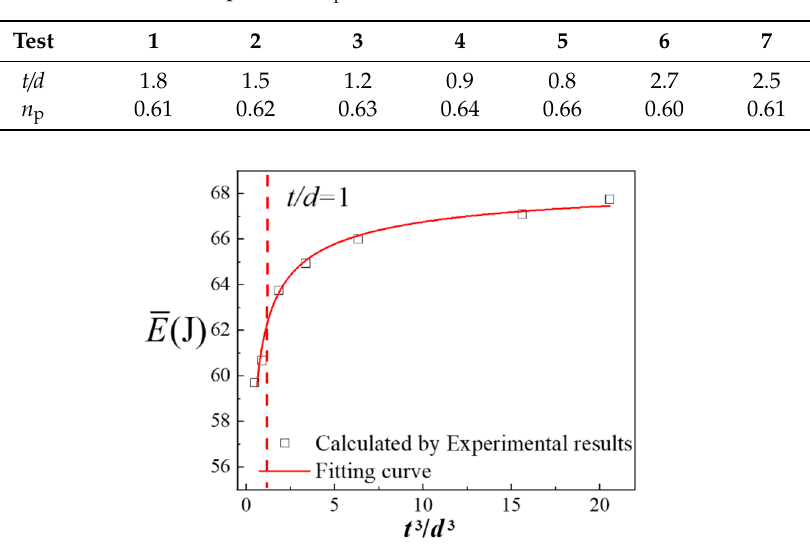
Table 4. Optimized n p value based on the new model.